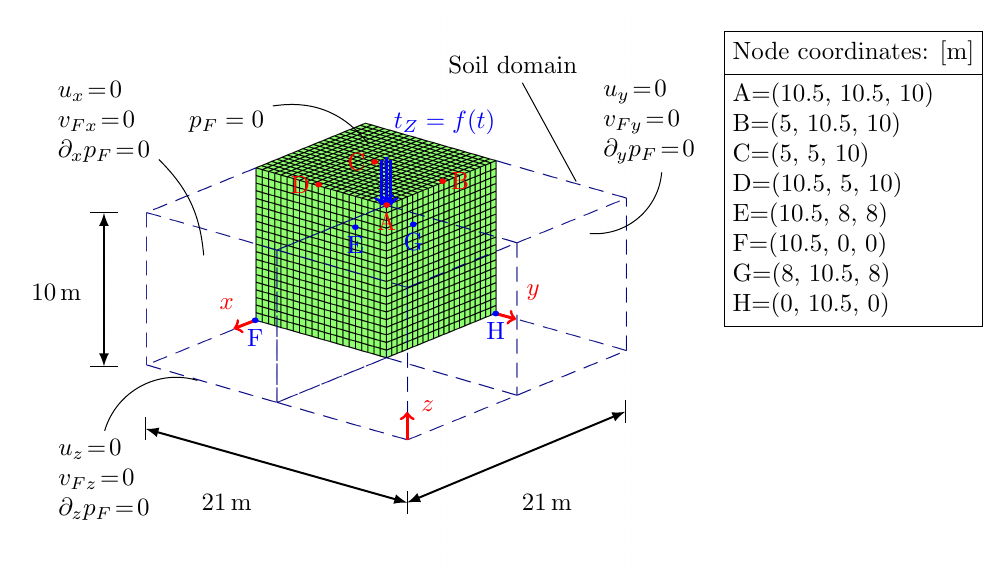
Figure 7. Three-dimensional soil